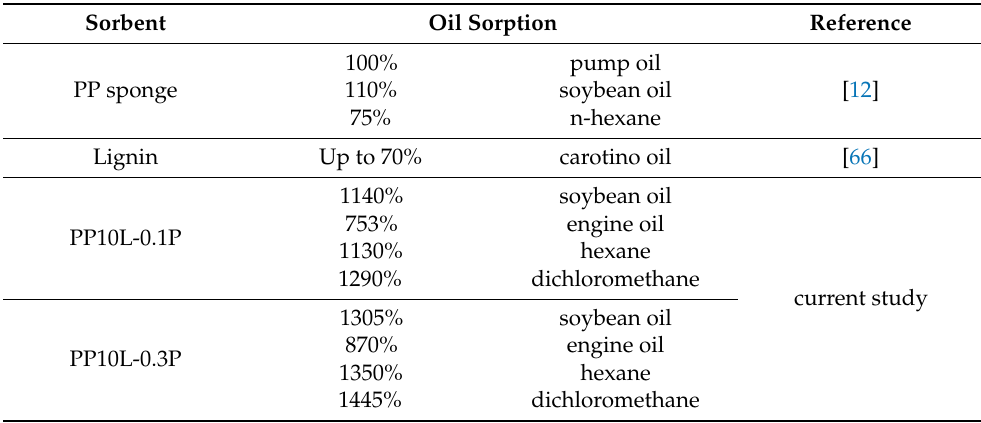
Figure 13. Recyclability of the PP10L-0.3 P sponge for the sorption of hexane. Table 7. Sorption of